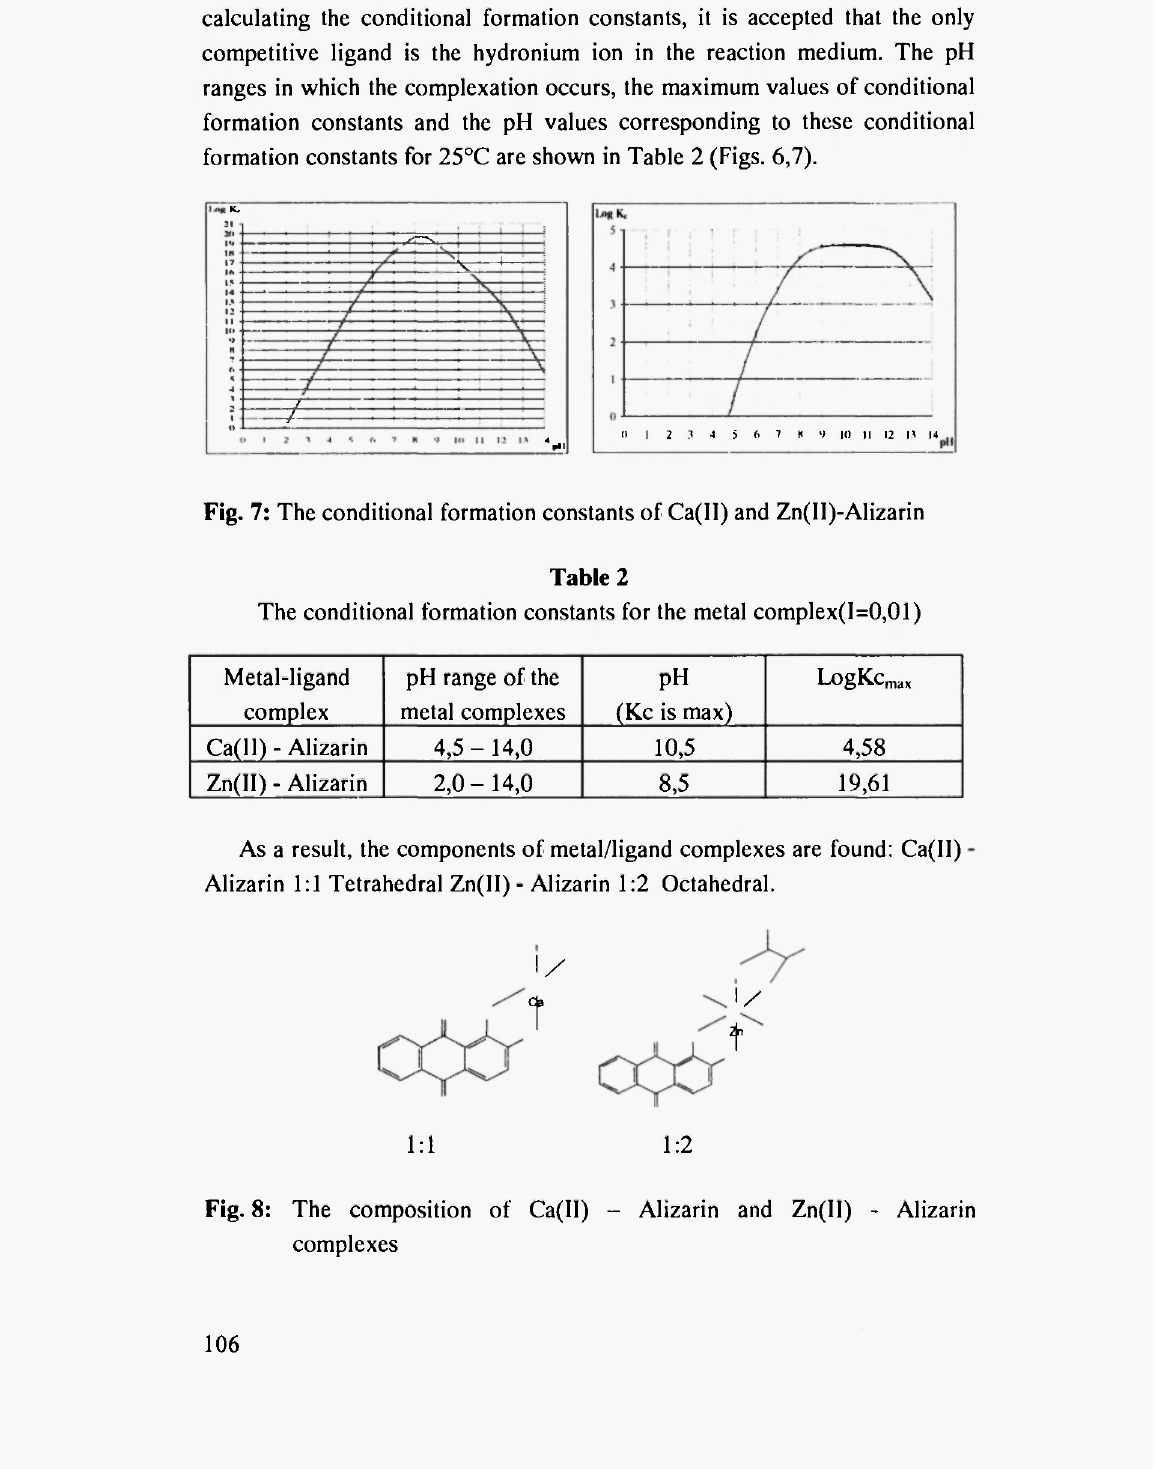
Fig. 7: The conditional formation constants of Ca(II) and Zn(II)-Alizarin